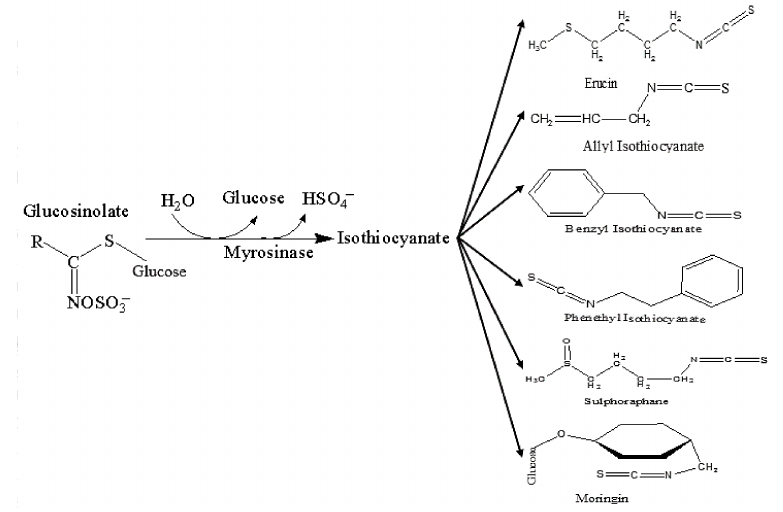
Myrosinase-catalyzed glucosinolate hydrolysis and chemical structure of selected isothiocyanates. Adapted from Sharma and Kapoor